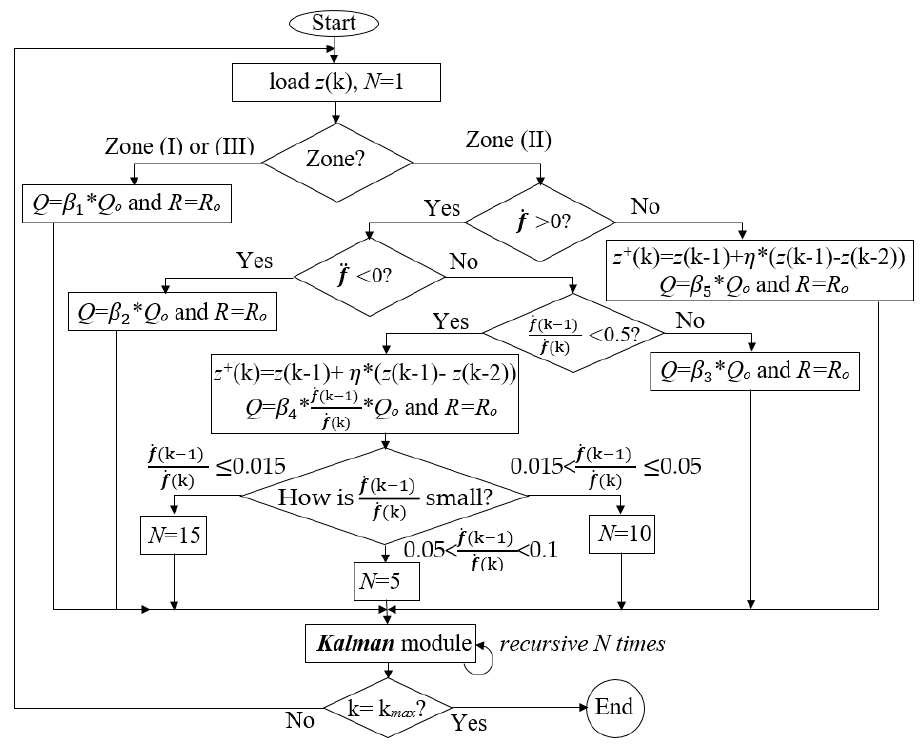
Figure 4. The algorithm of the adaptive-cognitive Kalman filter (ACKF). Based on N ; the Kalman can recall itself N